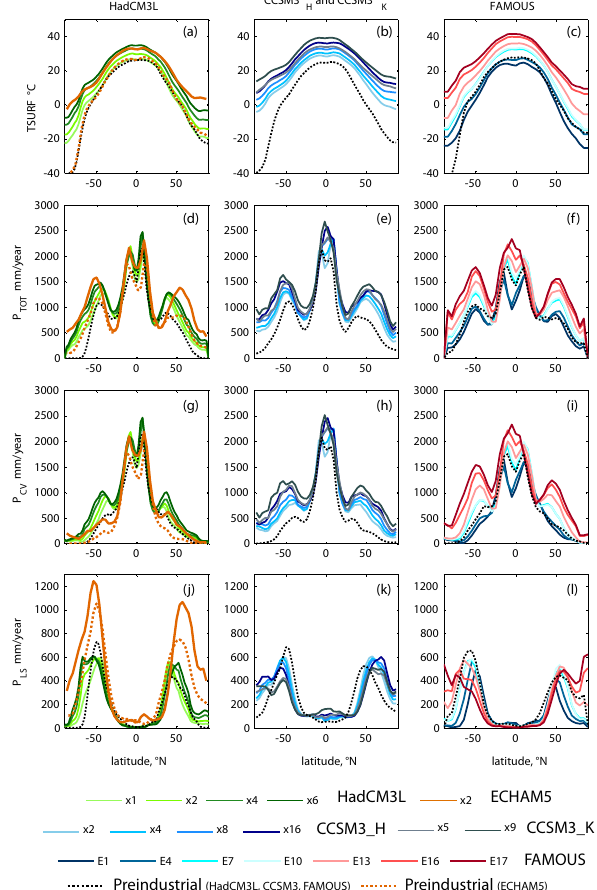
Figure 4. Latitudinal temperature and precipitation distributions in the HadCM3L and ECHAM5 (left), CCSM3 (H) and CCSM3 (K) (centre), and FAMOUS (right) members of the EoMIP ensemble. Panels (a–c) show mean surface air temperature, (d–f) total pre- cipitation rate, (g–i) convective precipitation, and (j–l) large-scale precipitation. The HadCM3L, ECHAM5, and CCSM3 atmospheric CO 2 levels are shown in the key. All FAMOUS simulations are x2 CO 2 but differ in value for 10 uncertain parameters (Sect. 2). Simu- lation names E1–E17 shown in the legend correspond to those given by Sagoo et al. (2013). Black dotted lines show output from prein- dustrial simulations, with the exception of ECHAM5, shown in or-